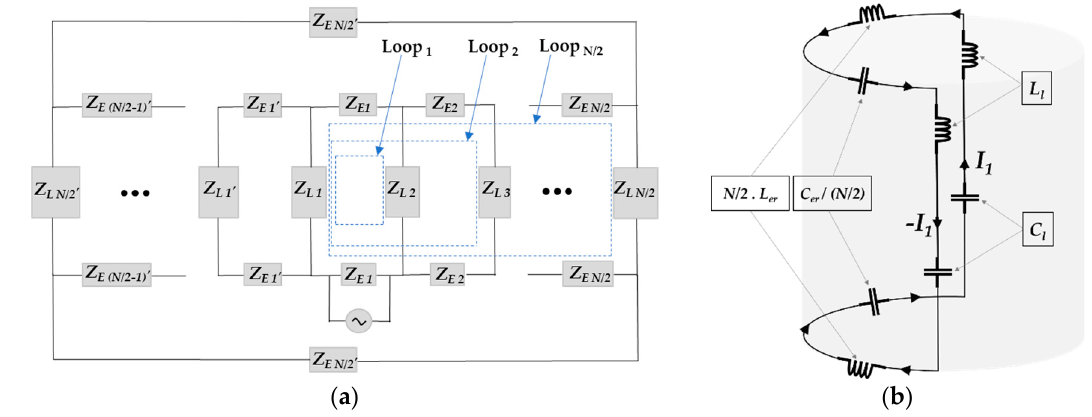
Figure 2. Schematic diagrams of the equivalent circuit of the birdcage coil showing. ( a ) the closed loops for leg currents; ( b ) dominant Resonance Path [36].